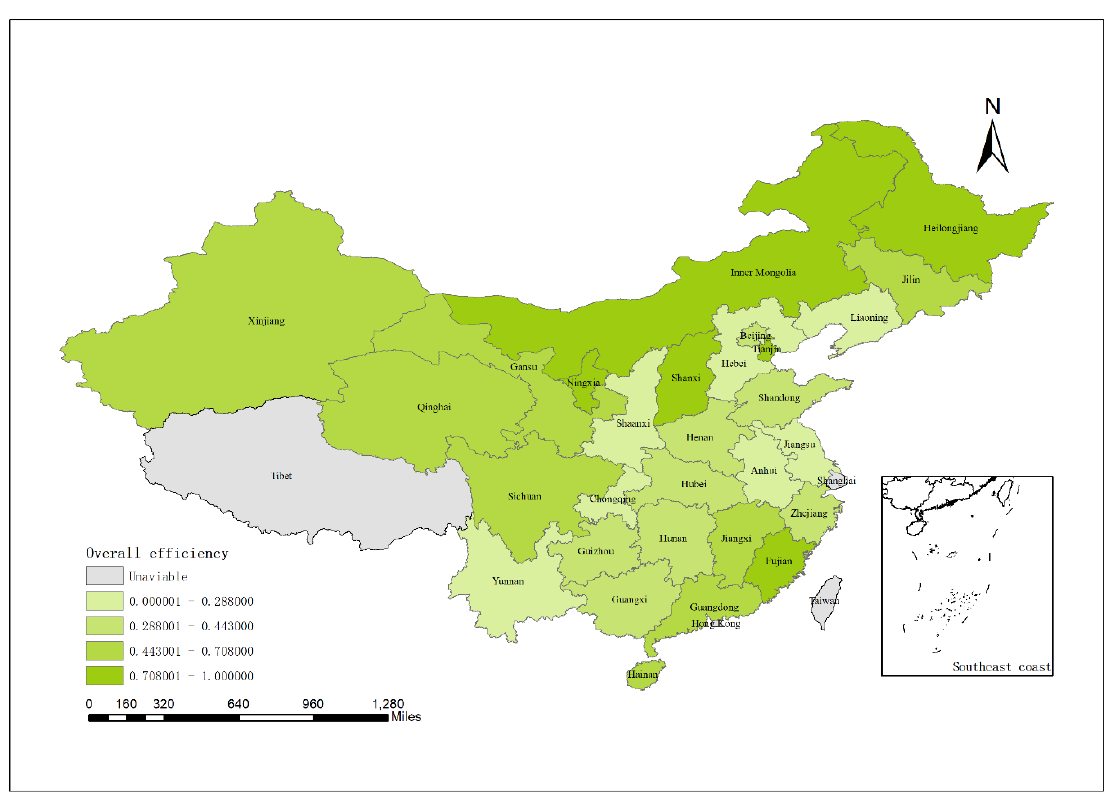
Figure 2. Overall efficiency for each province. Figure 2. Overall e ffi ciency for each